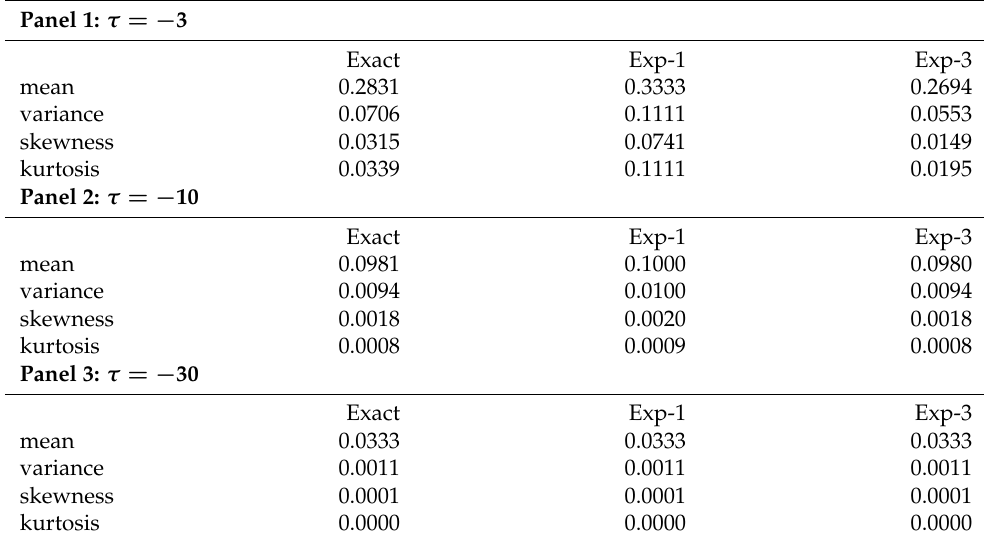
Table 2. Moments of the truncated normal distribution and its